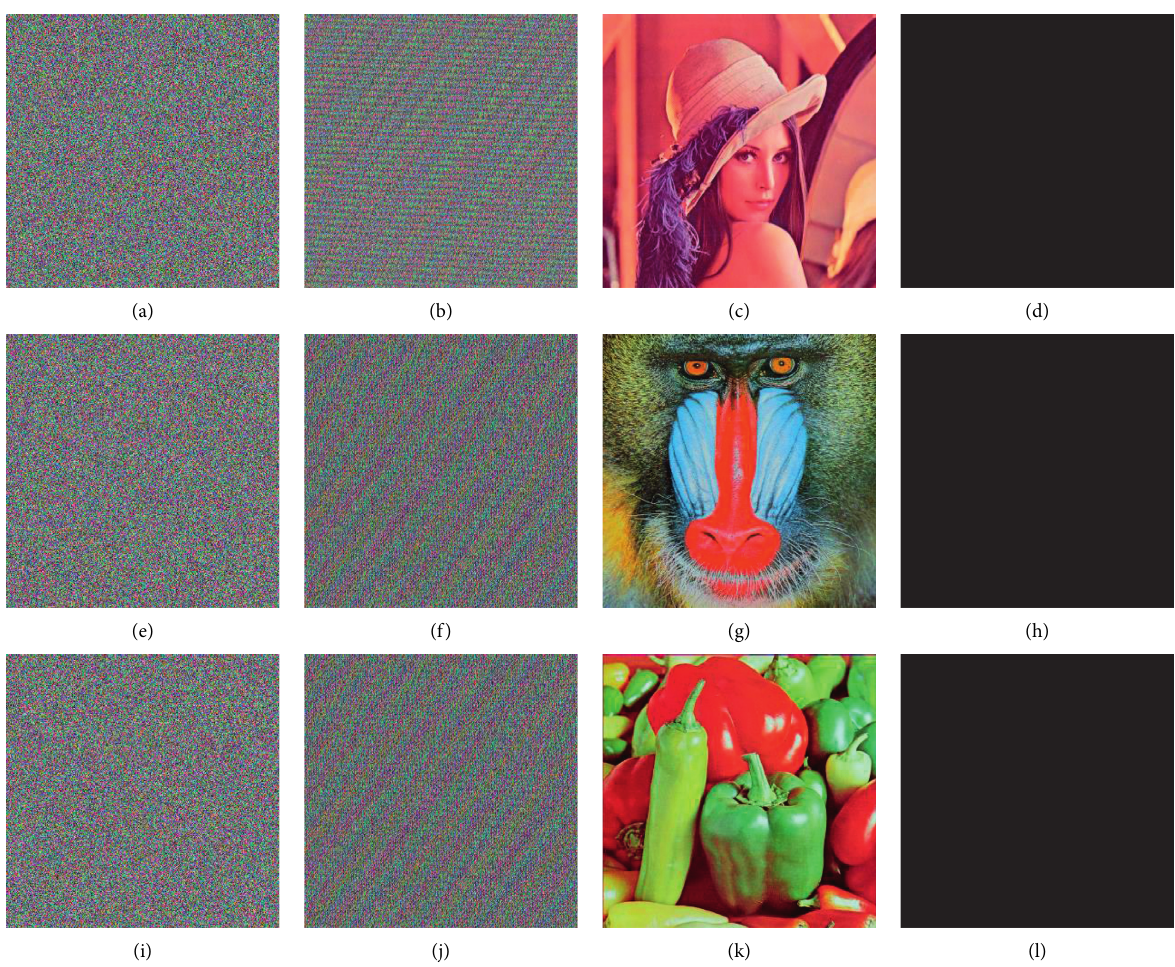
Figure 5: The breaking results on CIEA-HCNN with RGB color Lena, Baboon, and Pepper. (a) Lena ciphertext image. (b) Recovered permutation image of Lena. (c) Recovered plaintext image of Lena. (d) Difference image of Lena. (e) Baboon ciphertext image. (f) Recovered permutation image of Baboon. (g) Recovered plaintext image of Baboon. (h) Difference image of Baboon. (i) Pepper ciphertext image. (j) Recovered permutation image of Pepper. (k) Recovered plaintext image of Pepper. (l) Difference image of